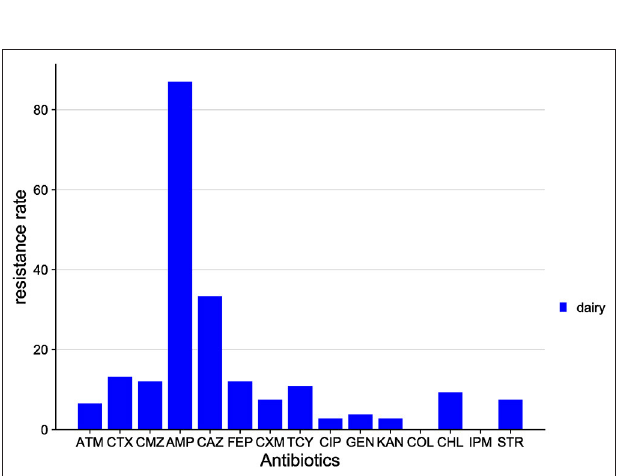
FIGURE 5 | Distribution of antibiotic resistant phenotypes in E. coli from Gansu.